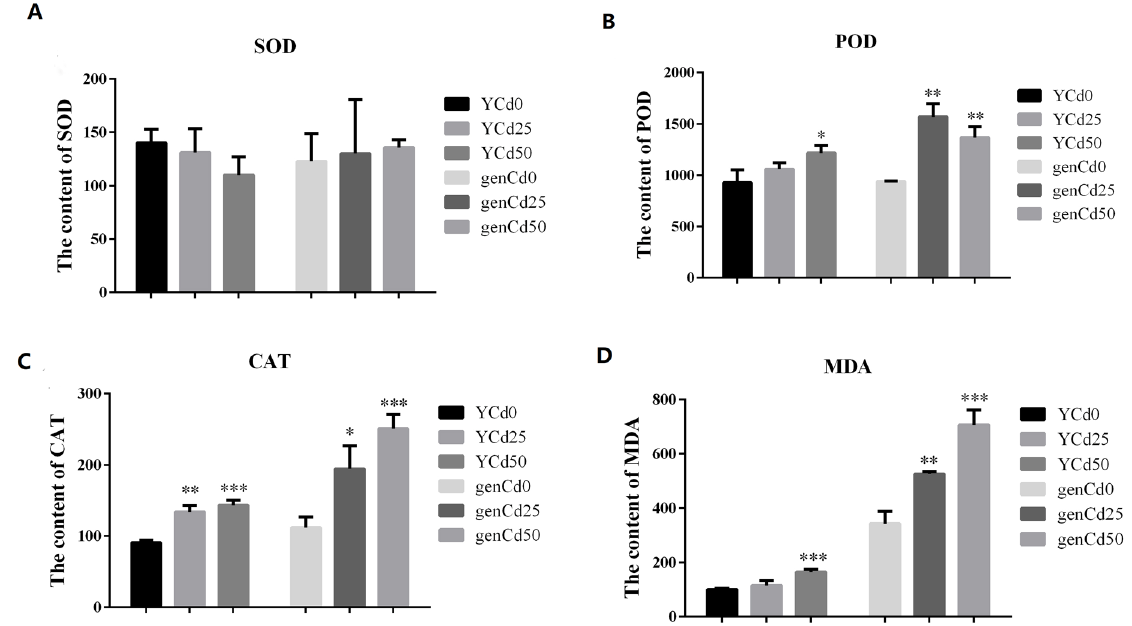
Figure 2. Activity of ( A ) SOD, ( B ) POD, and ( C ) CAT and content of ( D ) MDA in goldenrain tree treated with 0 mg/L, 25 mg/L, and 50 mg/L CdCl 2 for 3 days. Y = leaves; gen = roots. Values are the mean ± SE ( n = 3); * p < 0.05, ** p < 0.01, *** p < 0.001 (Tukey’s test).